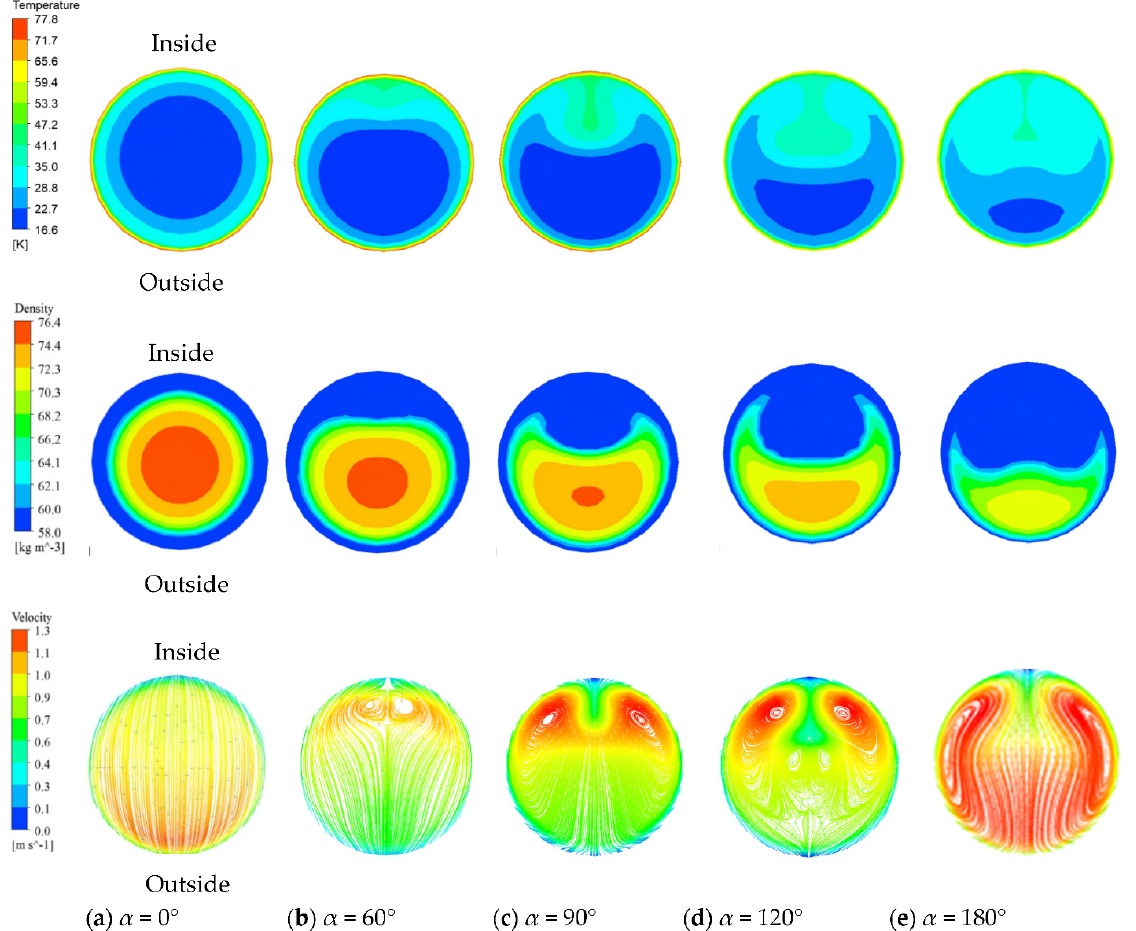
Figure 7. Temperature, density and velocity contours on the α section of the bend pipe with different bending angles.